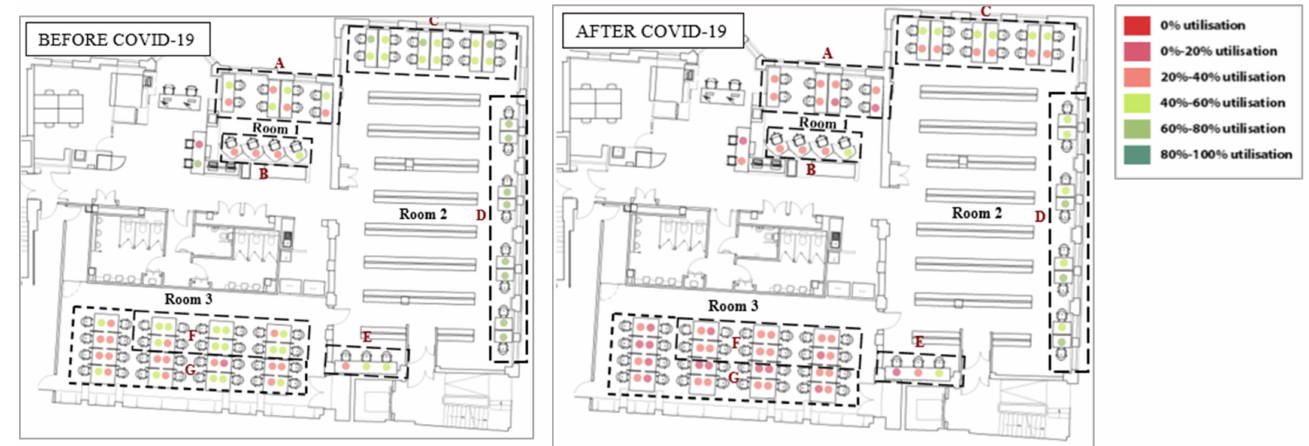
Figure 5. Change in the utilisation of the desks at the UCL Bartlett Library before and after the COVID-19